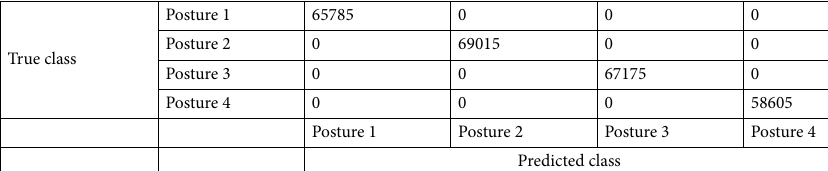
Table 1. Confusion matrix for Classifier 2 (posture classification) Posture 1: Standing, Posture 2: Sitting,Posture 3: Lying down, Posture 4: Legs outstretched. There were approximately 22.5 minutes (67,500 samples) of data per activity (maximum of 90 seconds per posture per day x 15